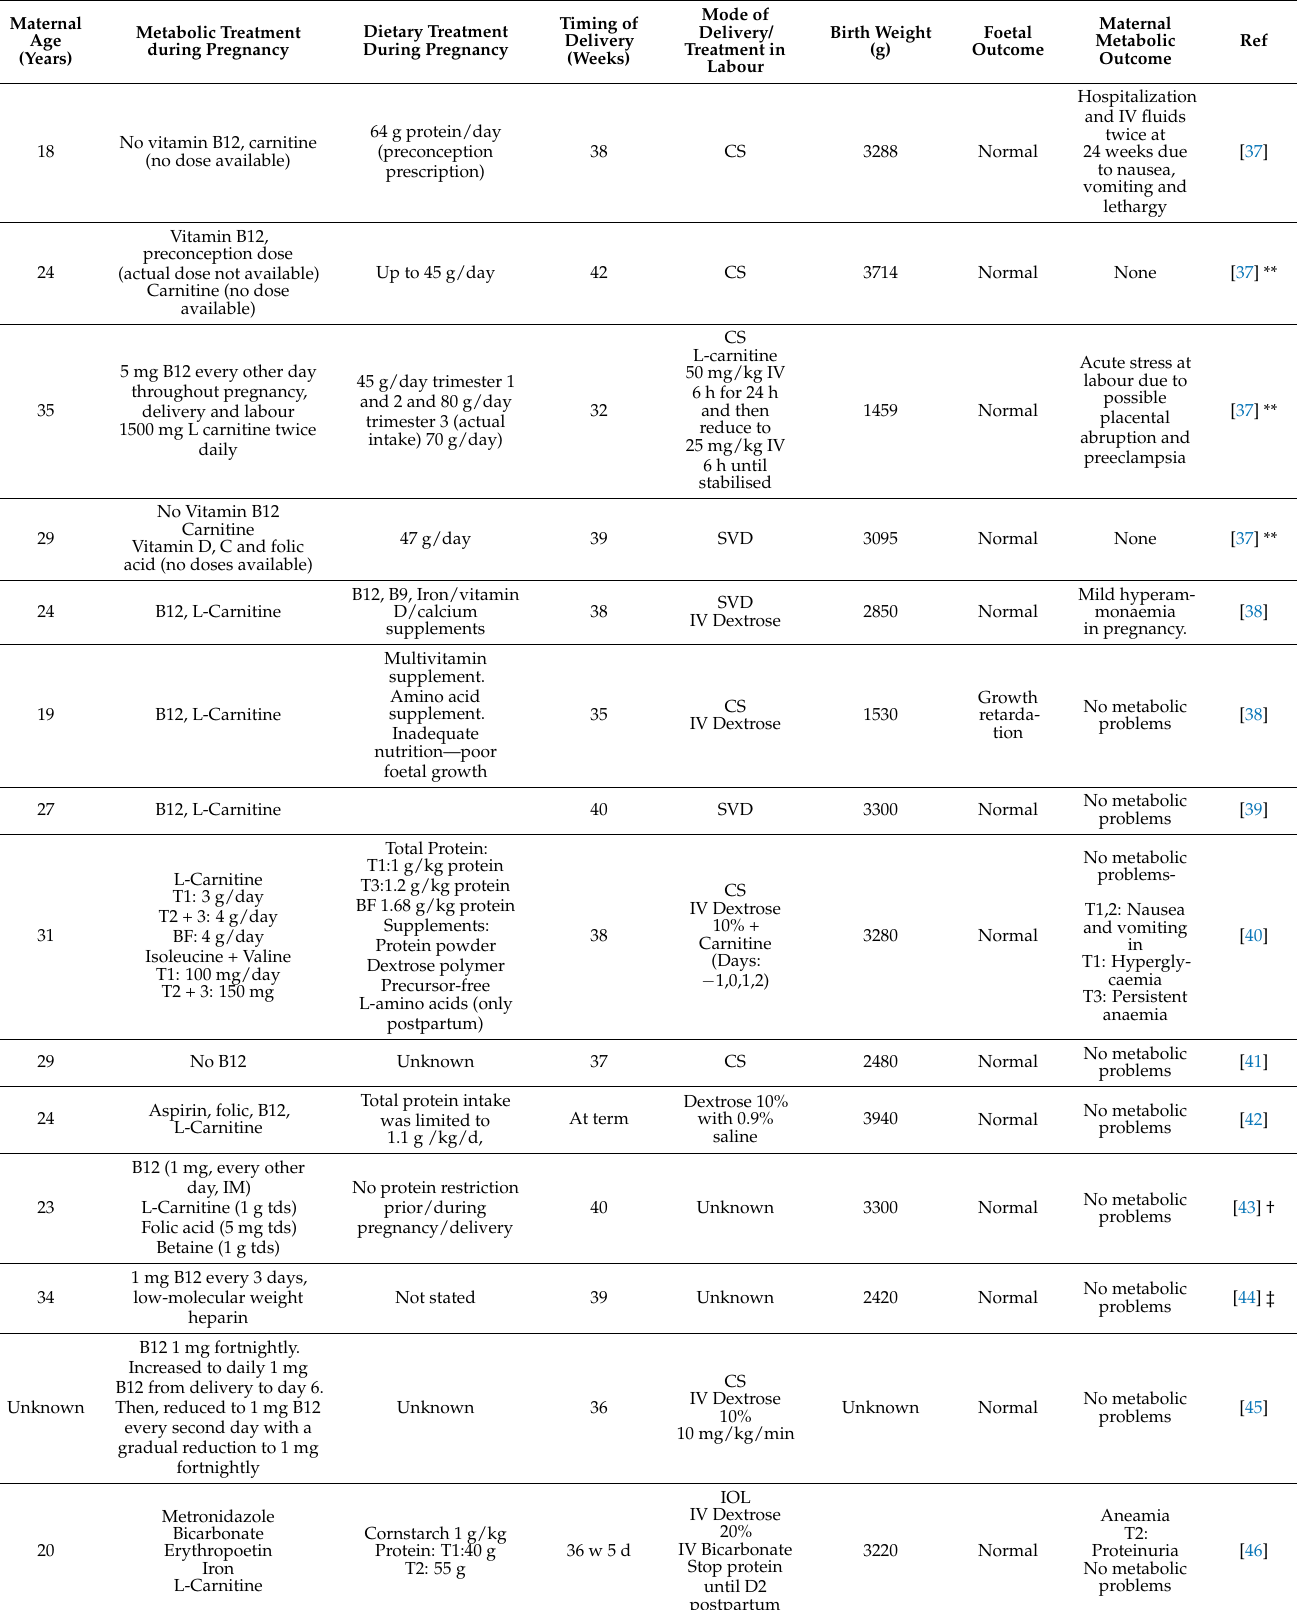
Table 4. Published literature on pregnancies in